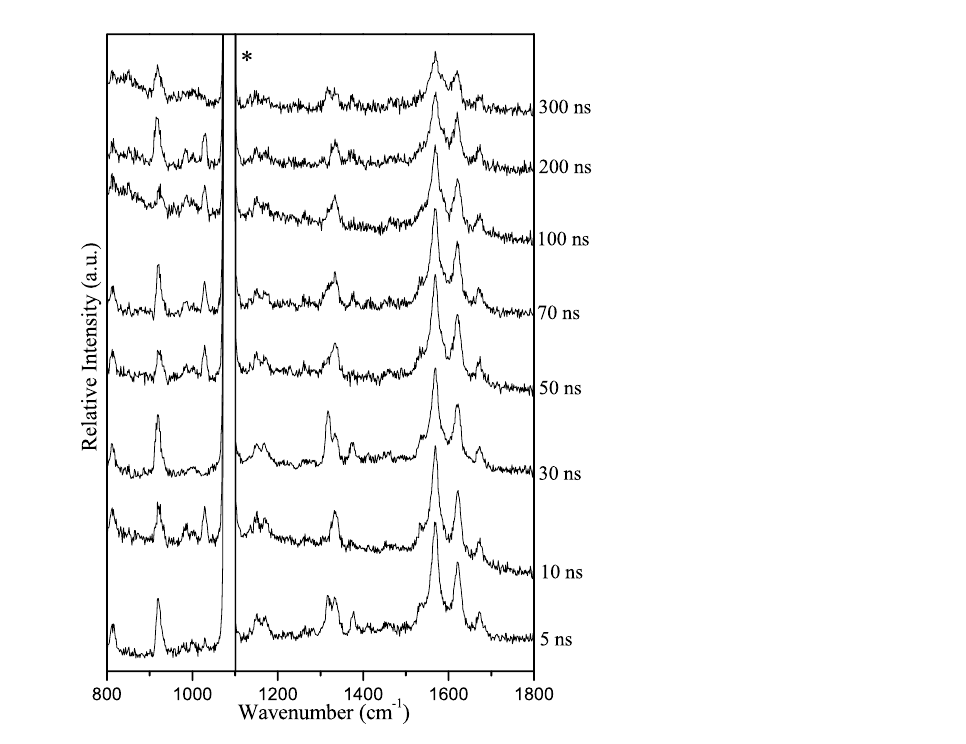
Figure 6. The ns-TR 3 spectra of PPAQ after 266 nm photoexcitation in MeCN using a 416 nm probe wavelength at various time delays indicated next to the spectra are shown. The asterisk ( * ) marks regions affected by stray